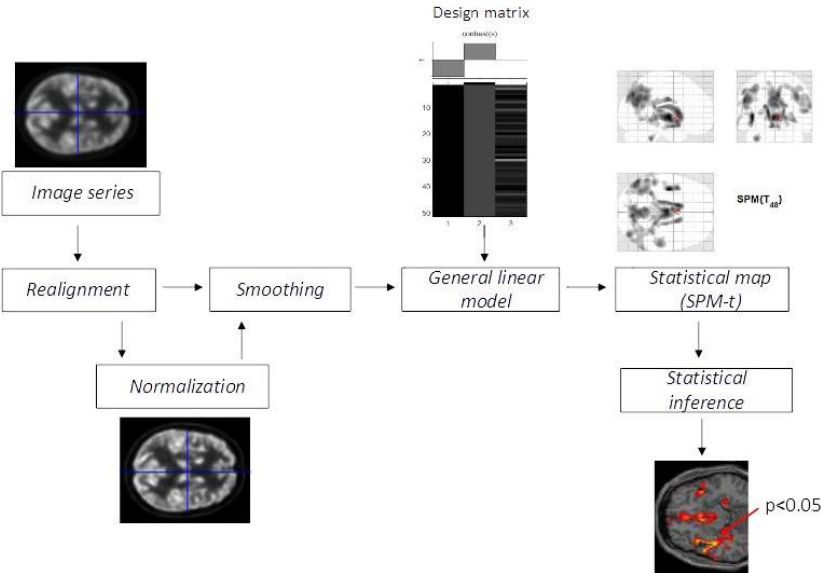
Figure 1. Flow chart of FDG-PET image pre-processing. The colour-coded areas (red arrow) indicate the locations where the voxel values of a patient are significantly different from the normal control group.